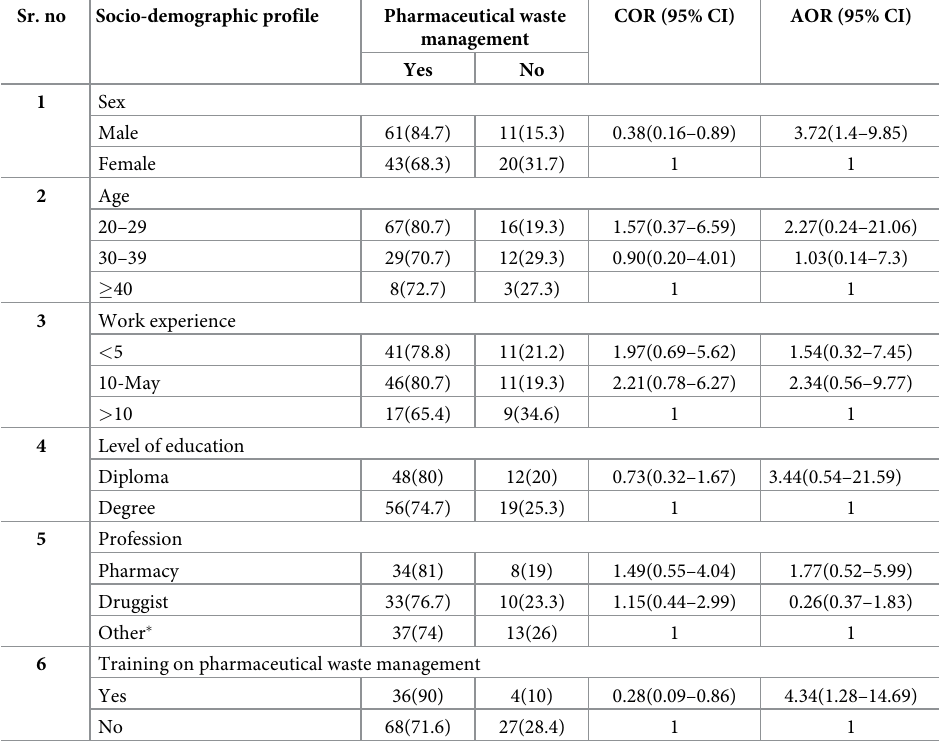
Table 6. Socio-demographic factors associated with pharmaceutical waste management in public health facilities of Dessie town. Sr.